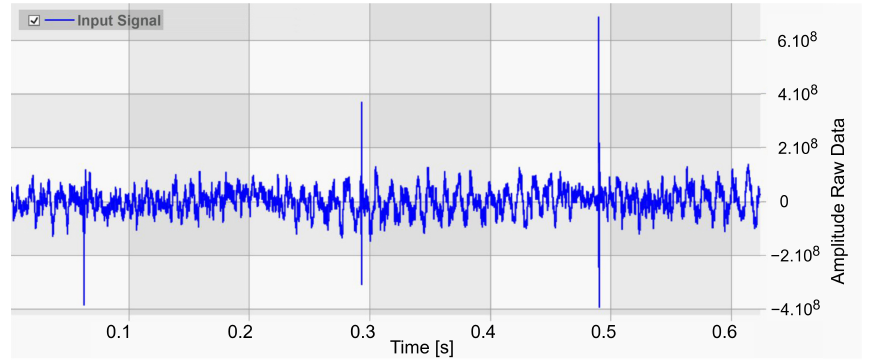
Figure 9. Cetacean click signal in output of the charge amplifier. Three clicks are present in the signal as well as sea noise.